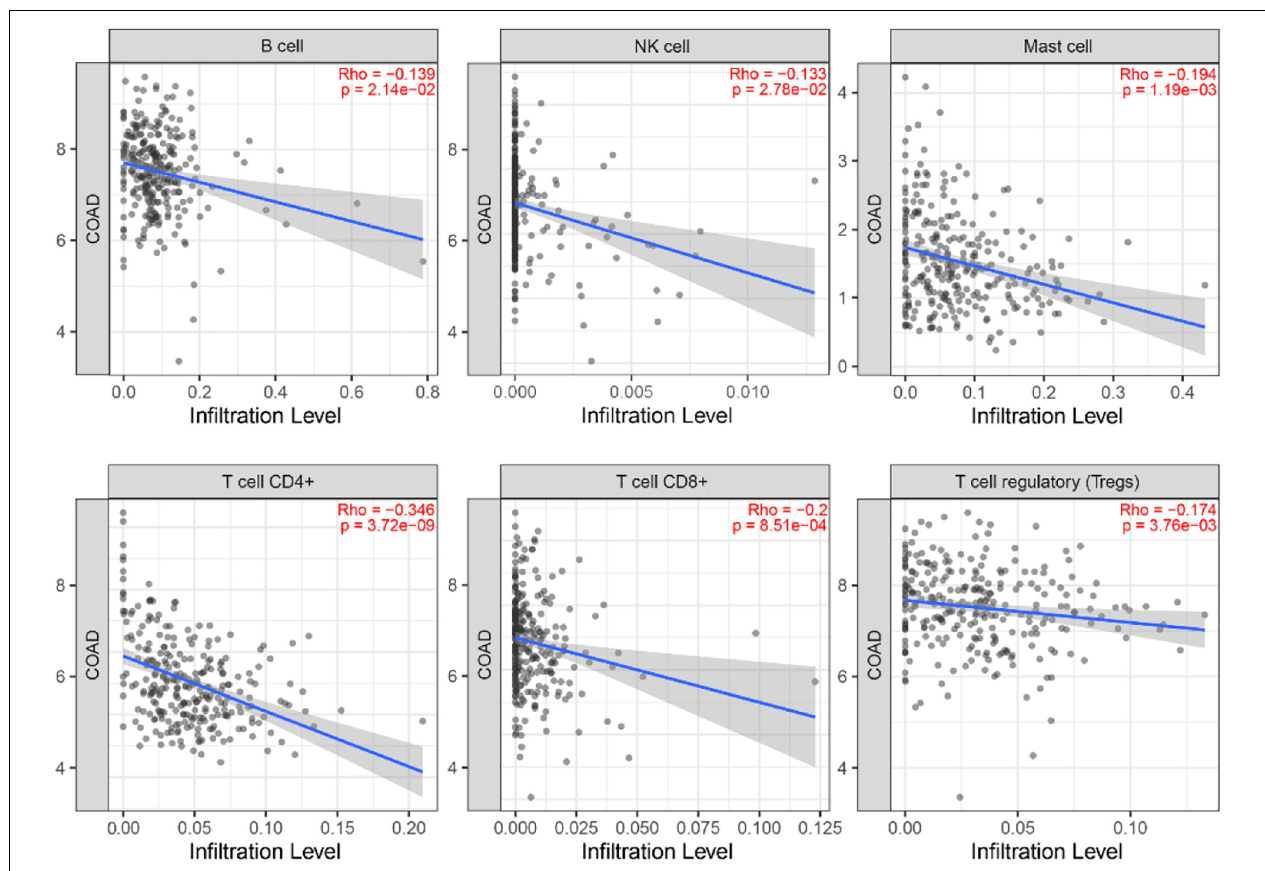
FIGURE 12 | Correlation of MYC expression with immune infiltration level in the TIMER database.